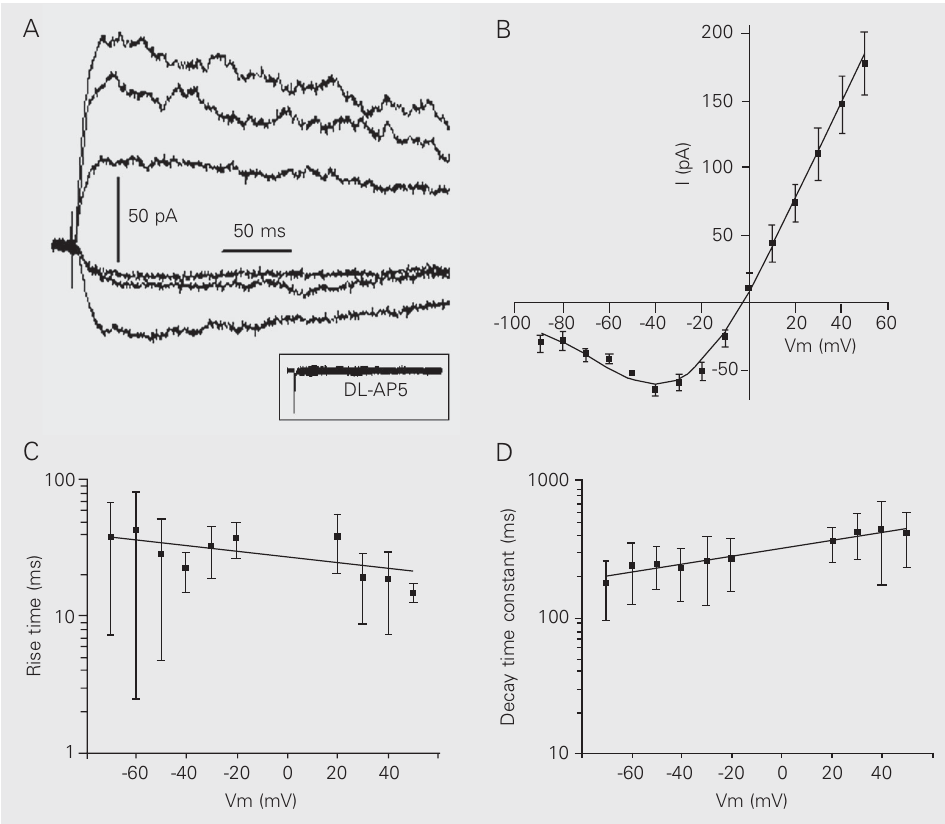
Figure 1. N -methyl-D-aspartate (NMDA) receptor-mediated currents recorded from secondary neurons of the nucleus tractus solitarius of the rat. A , Pharmacological isolation of the NMDA excitatory postsynaptic currents by perfusion with bicuculline (50 µM), strychnine (5 µM) and DNQX (5 µM). Holding potentials varied from -90 to +50 mV in 10-mV steps. The traces shown correspond to the following voltages: -70 (lowest trace), -30, 0, +20, +40, and +50 mV (uppermost traces). Addition of DL-2-amino-5-phosphonopentanoic acid (DL-AP5, 50 µM) to the bath completely abolished the synaptic currents (inset). B , I-V relationship of the NMDA responses showing the characteristic “ J ” shape, with a region of negative slope conductance. The reversal potential estimated from the fit was -2.1 ± 7.3 mV and peak inward current occurred near -40 mV (-38.7 ± 4.2 mV). C , Plots of excitatory postsynaptic current rise time against the membrane potential. Note that the rise time tends to be faster with depolarization. D , Plot of the decay time constant against the membrane potential. The decay time constants are dependent on membrane voltage, being prolonged by depolarization in an exponential manner (increasing e -fold per 145 mV). The average at -70 mV differed significantly from that at +50 mV (P < 0.05, Student t